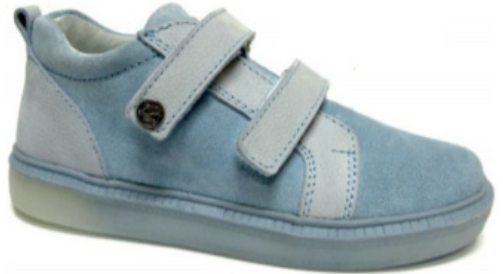
Figure 10. A model of the sports and leisure